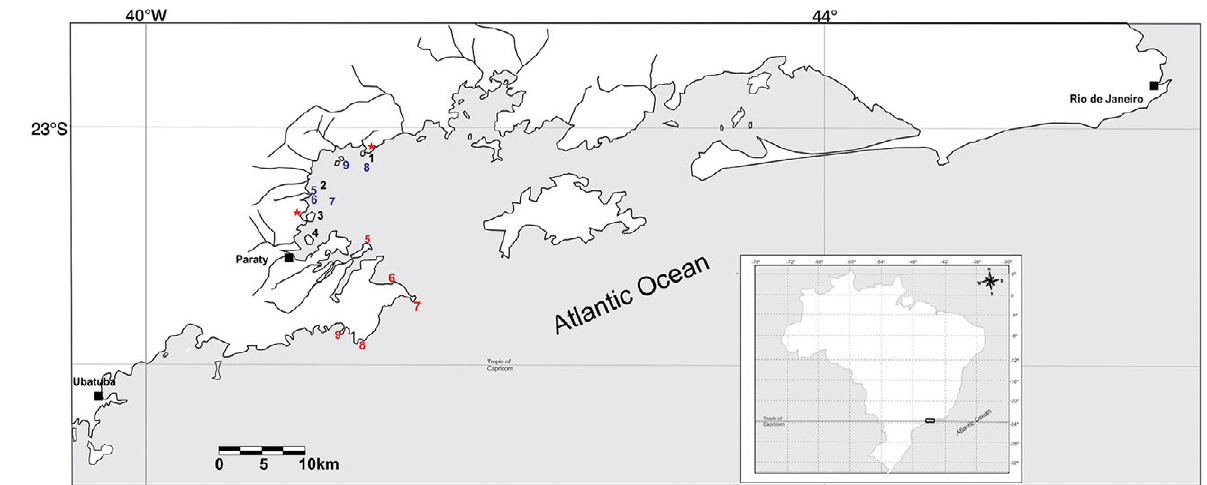
Fig. 1. – Map of Paraty artisanal fishing sites on the coast of the states of Rio de Janeiro and São Paulo, Brazil. Red stars indicate landing ports. The fishing spots that were used by the communities of Paraty to catch C. undecimalis (blue or black numerals: 1, Tarituba; 2, Ilha do Pico; 3, Ilha do Araújo; 4, Baía de Paraty; 5, Canto do Morro; 6, Ilha do Ventura; 7, Ilha Rasa; 8, Aracaíba; 9, Laje Sete Cabeças) and E. marginatus (red or black numerals: 1, Tarituba; 2, Ilha do Pico; 3, Ilha do Araújo; 4, Baía de Paraty; 5, Ilha do Algodão; 6, Cajaíba; 7, Joatinga; 8, Ponta Negra; 9, Sono). Table 1. – Details of the Centropomus undecimalis and Epinephelus marginatus sampling sites, with the number of individuals (N) and their average length and weight. (—) indicates no data collected. Species